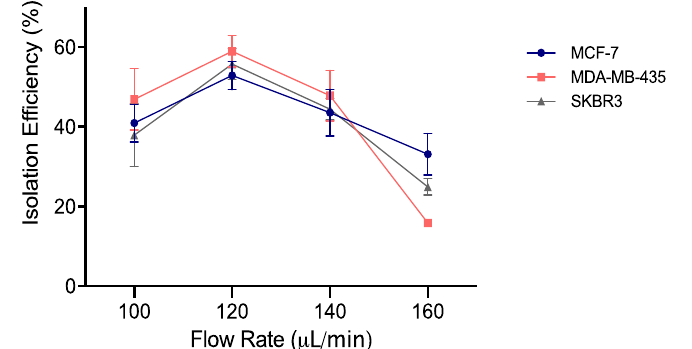
Figure 2. Graphical representation of the isolation efficiency of the RUBYchip™ at four different flow rates, with three different cell lines, MCF-7, MDA-MB-435 and SKBR3. The highest results were achieved at 120 μL/min, for all the cell lines, with isolations of 53%, 59% and 56% for MCF-7, MDA-MB-435 and SKBR3 breast cancer cells, respectively, showing consistency of the results.